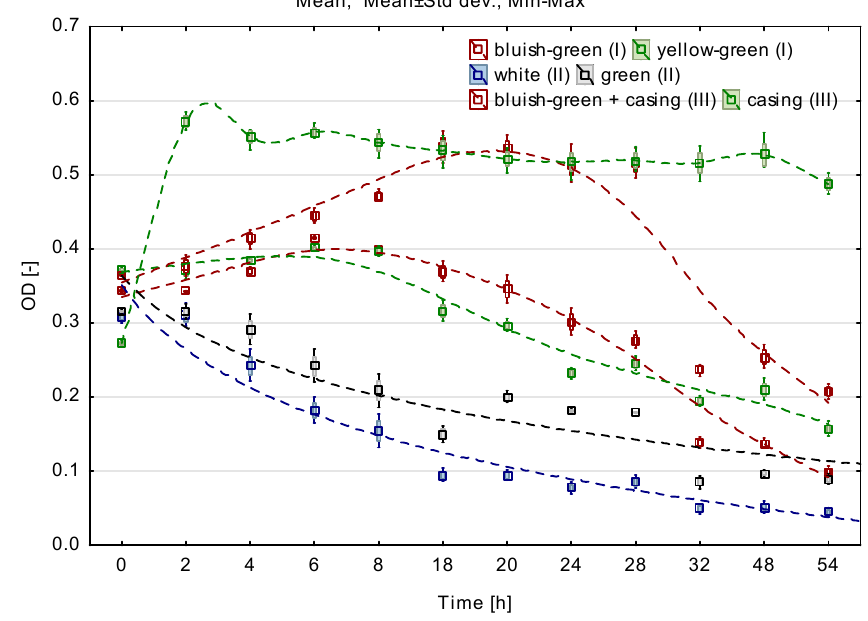
Figure 3. Optical density for batch culture using flexible PUFs from groups I–III. The highest affinity to microbial growth was observed during 48 h of culture in the presence of bluish-green elastic foam with open pores, additionally placed in a full casing. Similar values of optical density occurred during culture in the presence of bluish-green and yellow-green PUFs. The correlation coefficients between the OD values and the materials used to indicate similar growth conditions for microorganisms for both open-pore flexible foams (correlation coefficient 0.88), both closed-pore rigid foams (correlation coefficient 0.94), and the flexible bluish-green foam without casing and the one additionally placed in a conduit (correlation coefficient Table 2. Average content of biomass immobilized on waste PUFs from groups I–III after 48 h of batch culture .